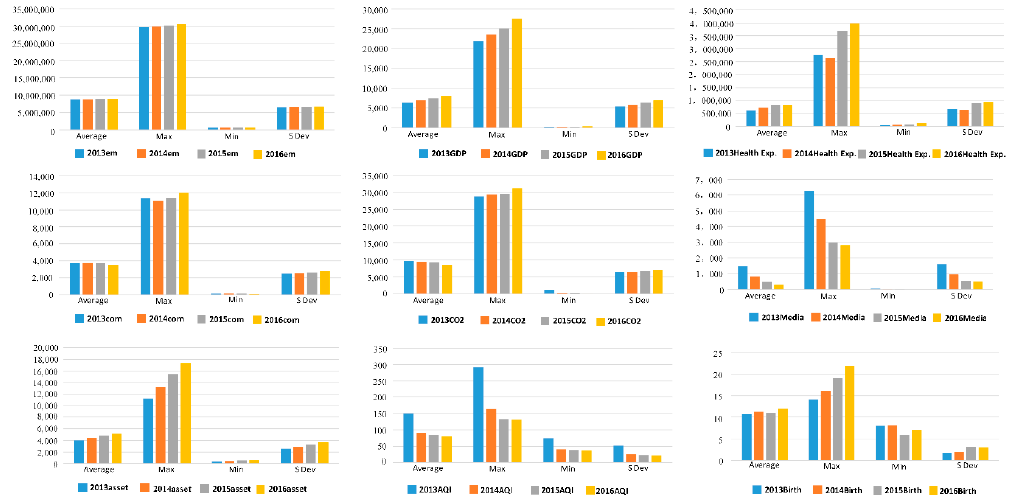
Figure 3. Input-output statistics.